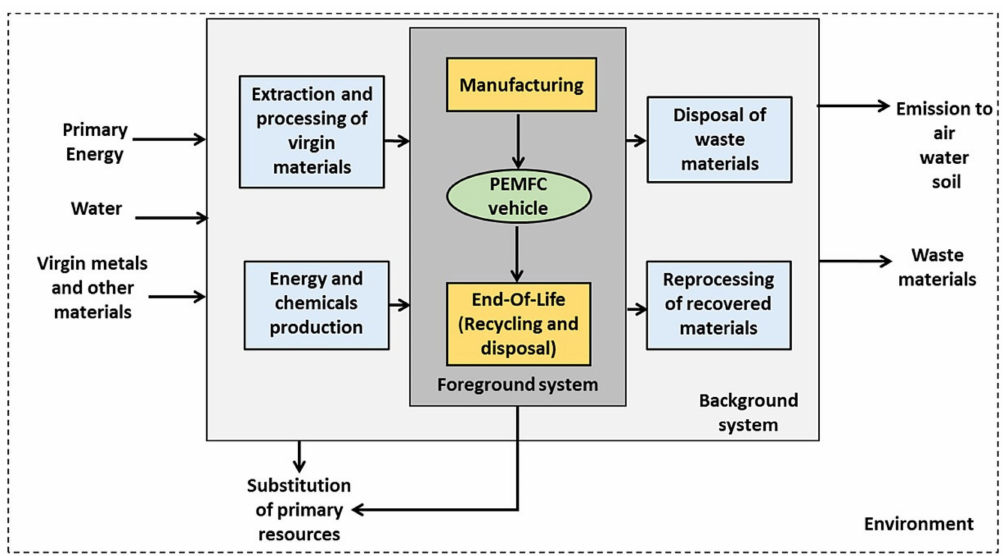
Figure 23. System boundary of the whole life cycle assessment of a polymer electrolyte membrane (PEM) fuel cell passenger vehicle. Reprinted from [96], © 2020 with permission from